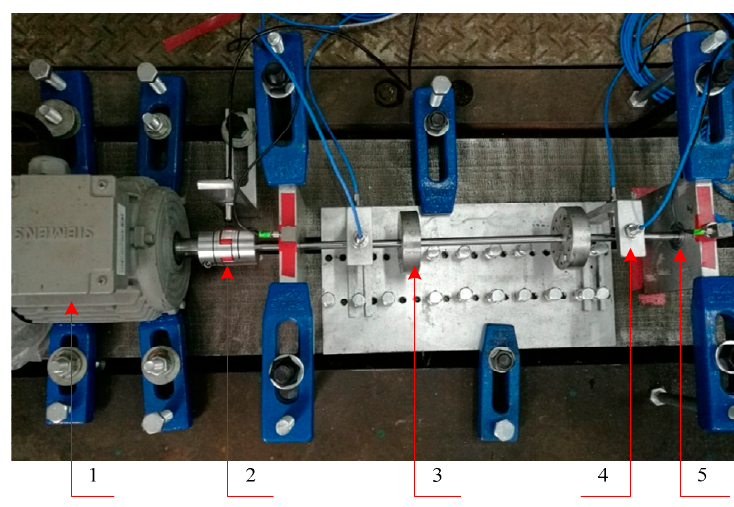
Figure 2. Rotor-bearing system for modal experiment. ( 1 ) Motor; ( 2 ) flexible coupling; ( 3 ) disc; ( 4 ) eddy current displacement sensors; ( 5 ) bearings. Table 2. Comparison of the natural frequencies from numerical calculation and experiment.